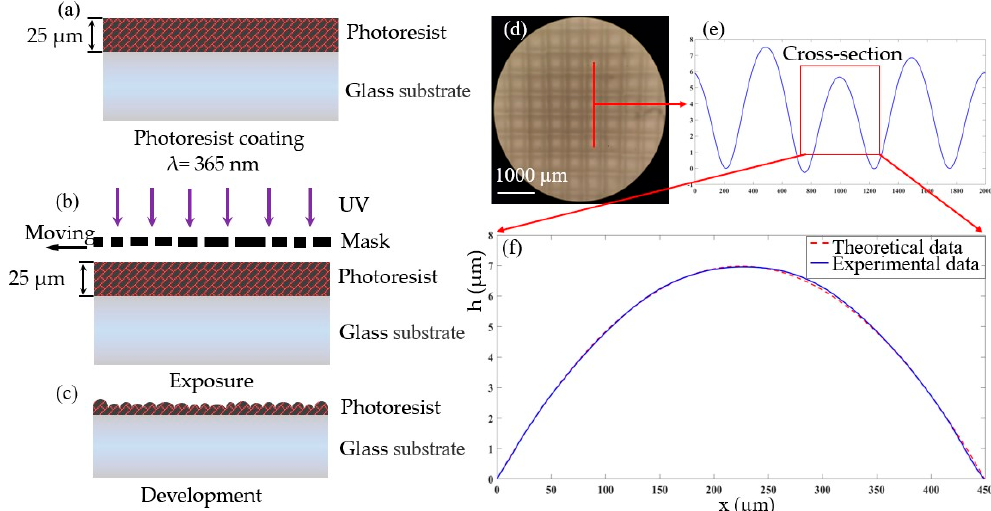
Figure 7. Preparation process and characterization of MLA: ( a ) Spin coated photoresist; ( b ) Moving mask exposure; ( c ) development; ( d ) 2D microstructure; ( e ) Contour representation; ( f ) Zoom in profile of the marked in; ( e ) Comparison between sub ‐ element contour and calculated profile.